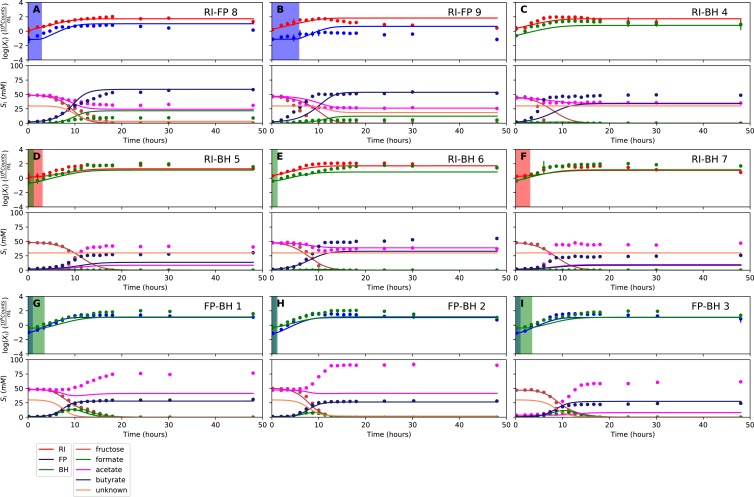
Fit to bi-culture experiments for the model parameterized on monocultures only.(A–B) Fit to Roseburia intestinalis L1-82 (RI) and Faecalibacterium prausnitzii A2-165 (FP) bi-culture experiments. (C–F) Fit to RI and Blautia hydrogenotrophica S5a33 (BH) bi-culture experiments. (G–I) Fit to FP and BH bi-culture experiments. Lines represent model predictions and dots represent observations. The whiskers represent technical variation across triplicates. The shaded regions indicate the length of the estimated strain-specific lag phases. The unknown compound represents an unspecified co-substrate assumed to be required by FP. Metabolites not included in the model are omitted from the plot. Experiment identifiers indicate which of the biological replicates is displayed. The model was parameterized on experiments RI_8, RI_14, FP_4, FP_15 and BH_14.